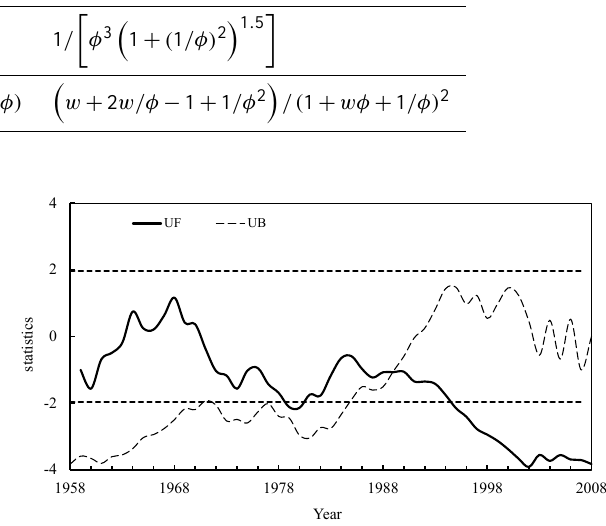
Figure 3 The result of the abrupt change point test in the Wei river basin 593 Figure 3. The result of the abrupt change-point test in the Wei River 594